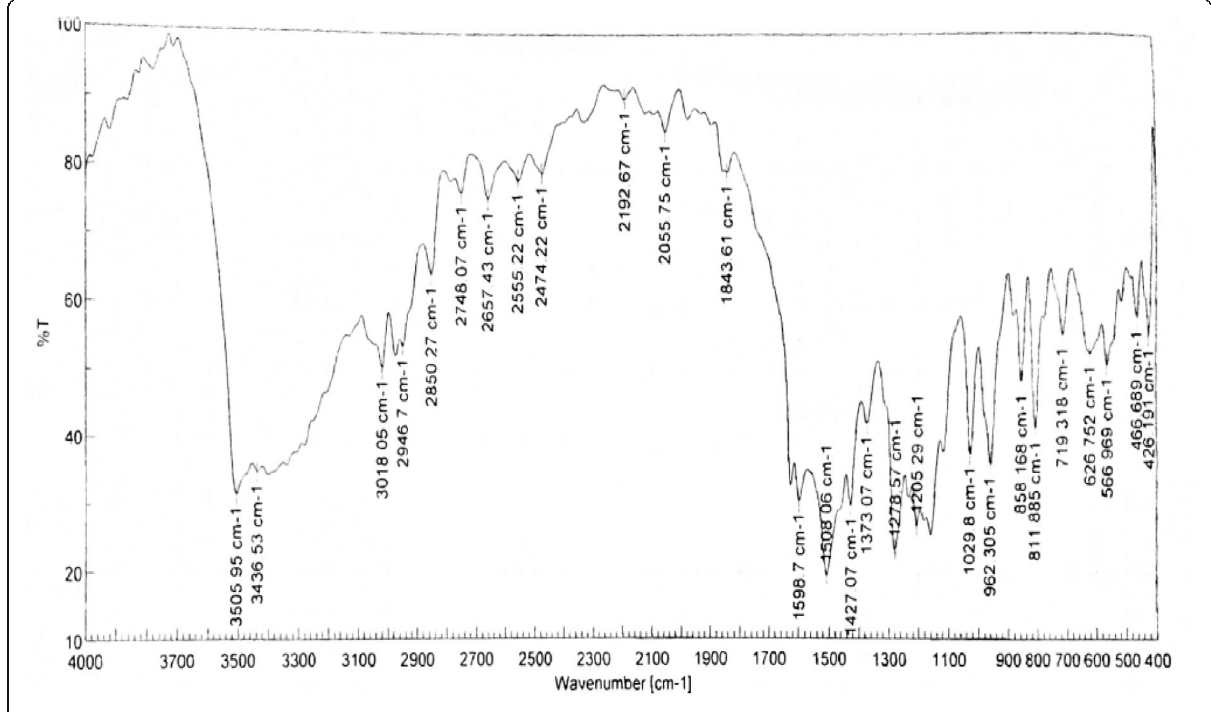
Fig. 3 Infrared spectrum of